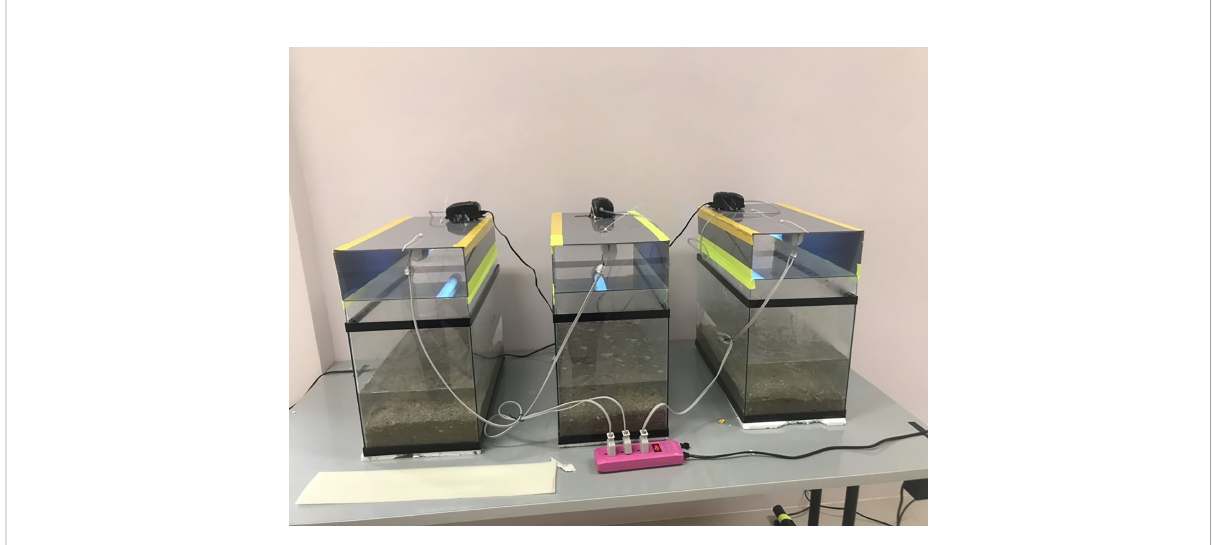
FIGURE 1 Experimental setup of biodegradable bioplastics under marine